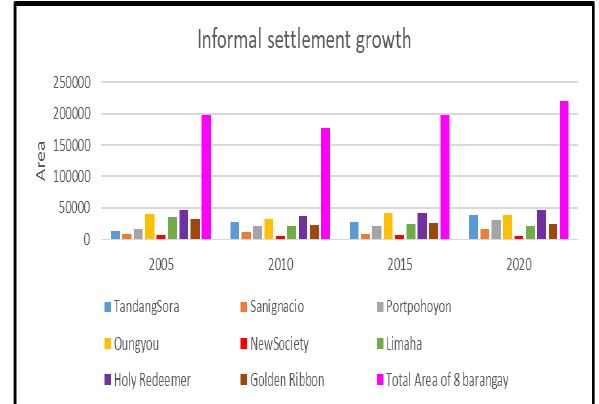
Figure 20. Overall total growth of areas of major informal settlements